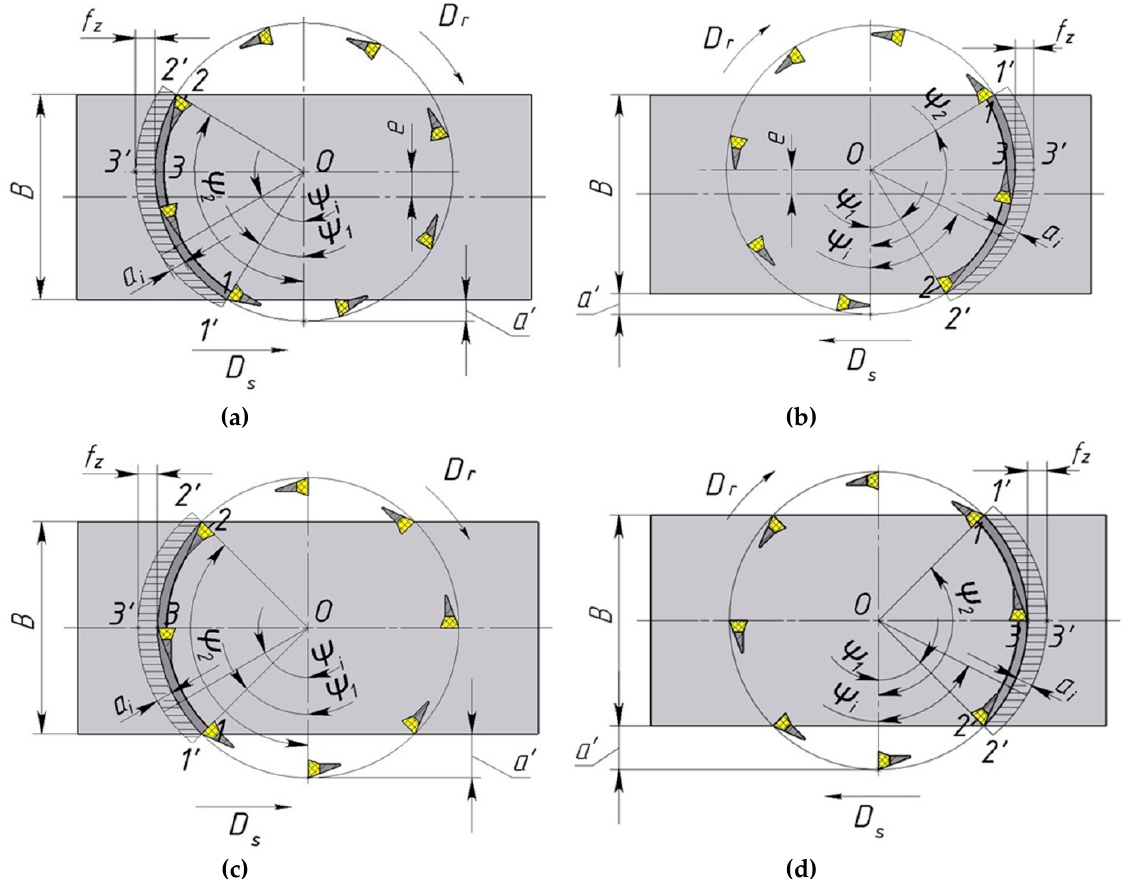
ψ ψ , a , uncut chip thickness; = 1 i in ψ , angular i D , direction of r